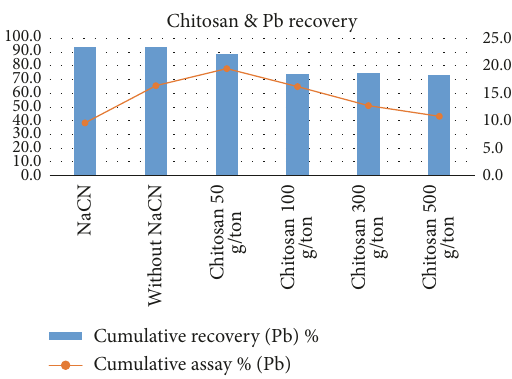
Figure 7: Lead recovery and concentrate grade as a function of chitosan dosage in comparison with NaCN